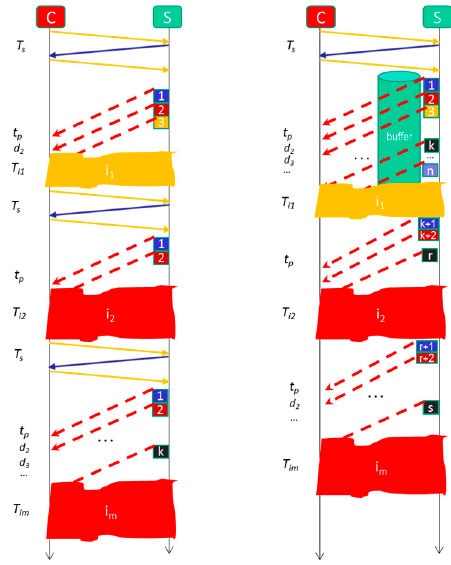
Figure 10. Communication times with video service disruptions and with the new method of mitigating the adverse effects of video service disruptions.